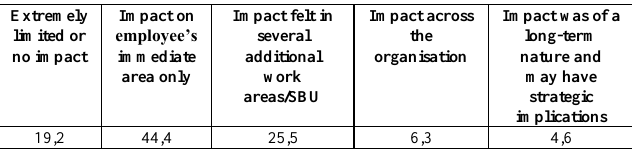
Table 8: Impact of selection error